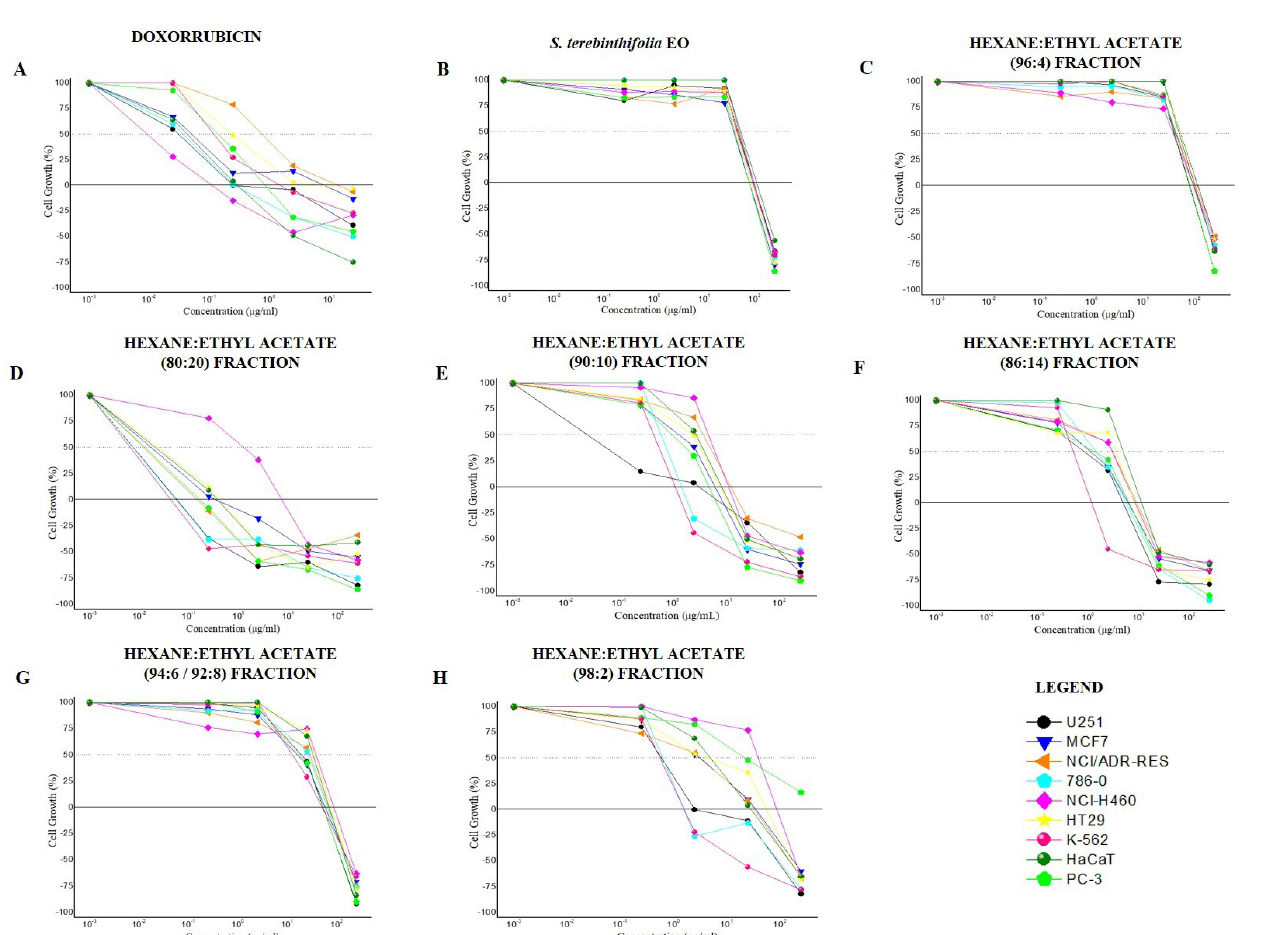
FIGURE 2 - Cell lines proliferation according to the concentration of positive control Doxorubicin (Figure 2A), S. terebinthifolia green fruits EO (Figure 2B) and its hexane: ethyl acetate fractions (Figure